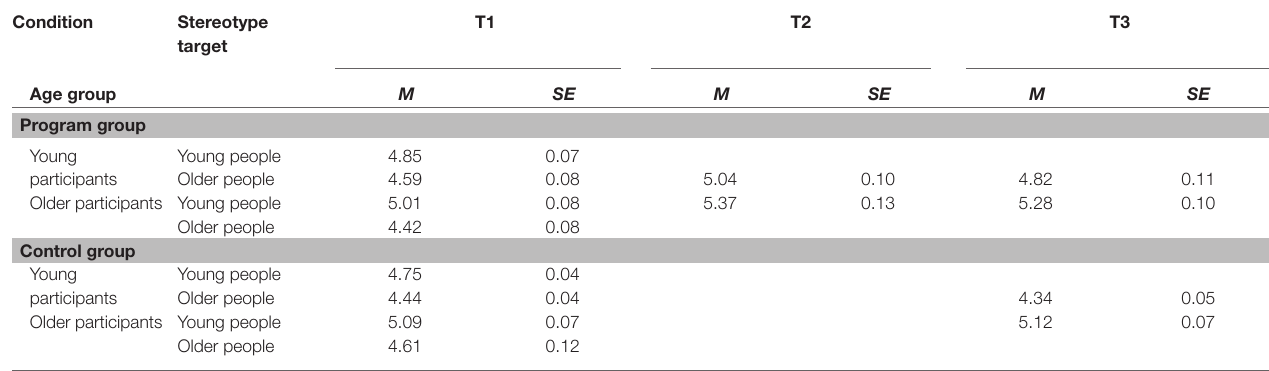
TABLE 2 | Descriptives ( M s and SE s) of age stereotyping in the program and control group condition across time (T1, T2, and T3).